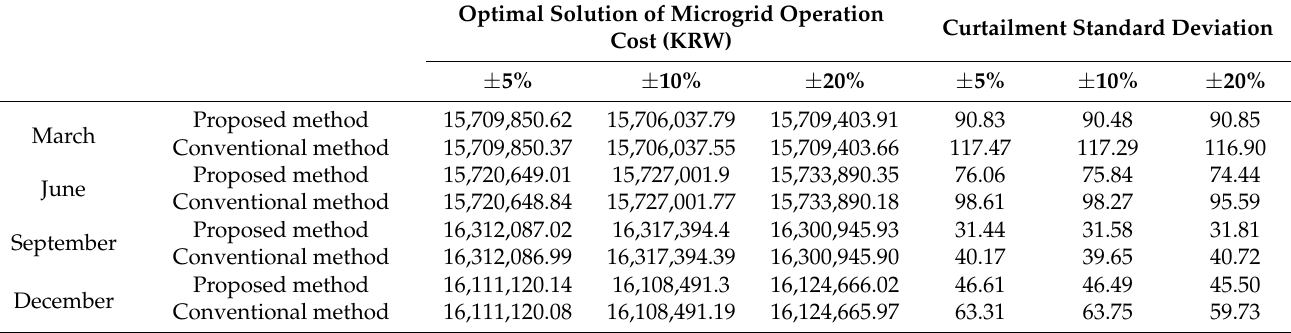
Table 5. Optimal microgrid scheduling results during generation time. Optimal Solution of Microgrid